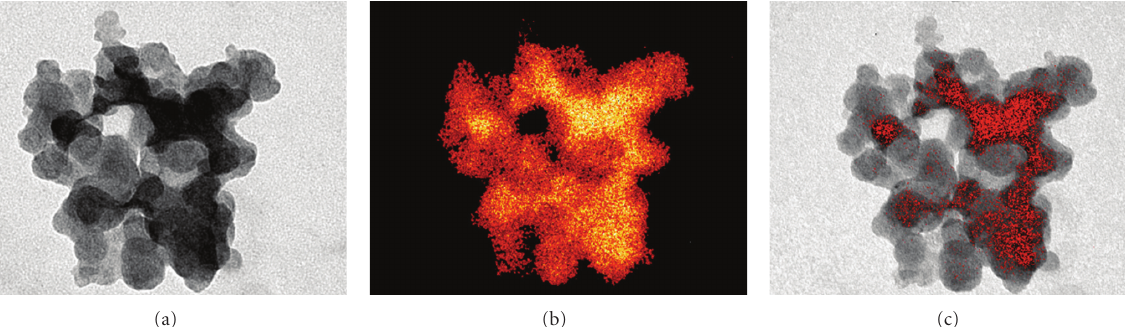
Figure 2: EFTEM micrograph of a cluster of liposomes (a). The ESI maps show a higher (b) and a lower (c) concentration of Cs entrapped in liposomes. Reproduced with permission from [131].